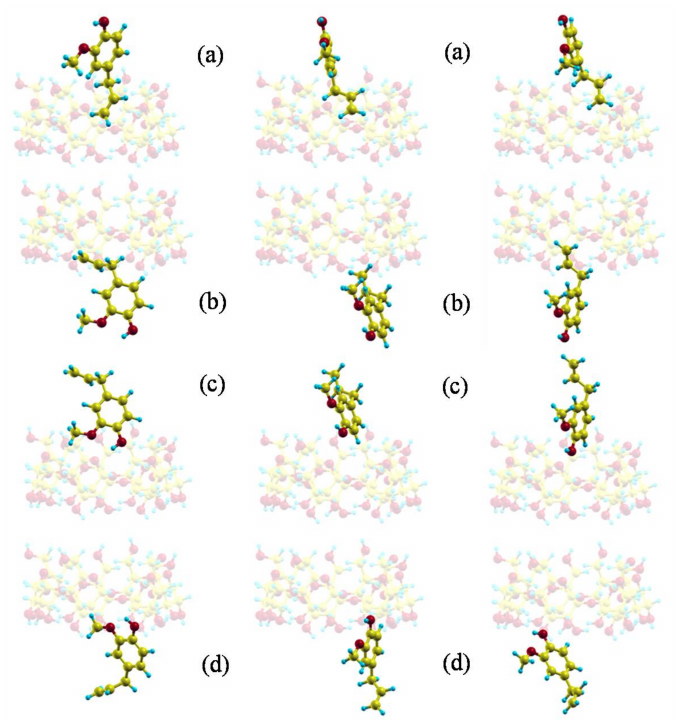
Figure 4. Starting dispositions of eugenol (EG) in the trajectories: ( a ) the guest centre of mass near the narrower rim of CD with the propene of EG pointing towards the cavity, ( b ) the guest centre of mass near the wider rim of CD with the propene of EG pointing towards the cavity, ( c ) the guest centre of mass near the narrower rim of CD with the phenyl ring of EG pointing towards the cavity, ( d ) the guest centre of mass near the wider rim of CD with the phenyl ring of EG pointing towards the cavity.